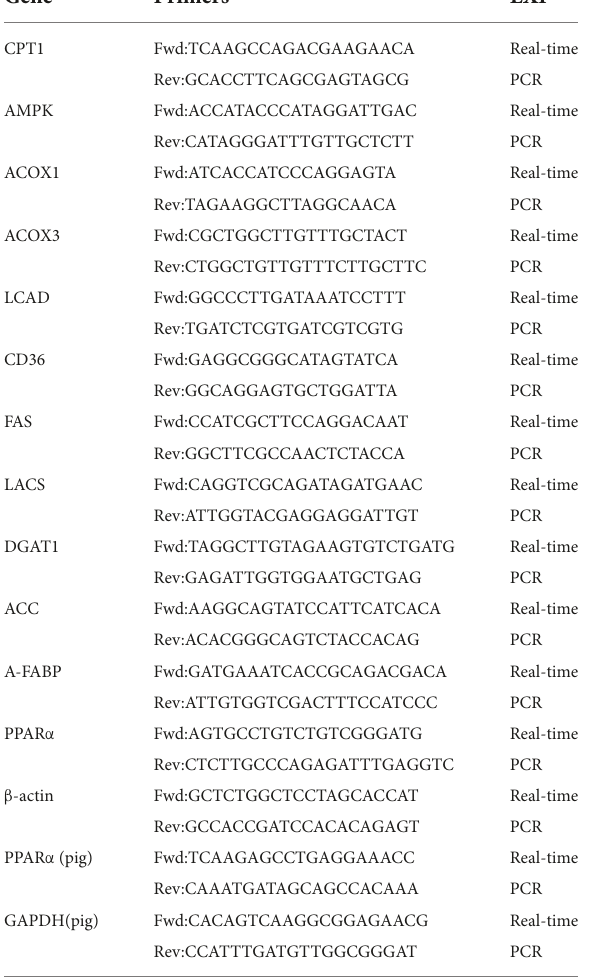
TABLE 3 Primers or oligonucleotides for real-time PCR (mouse or